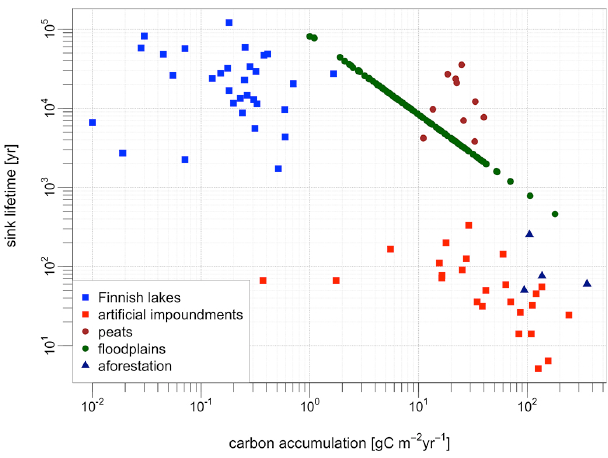
Figure 2. Lifetime versus sequestration rate of selected carbon pools. For details on data and calculations see